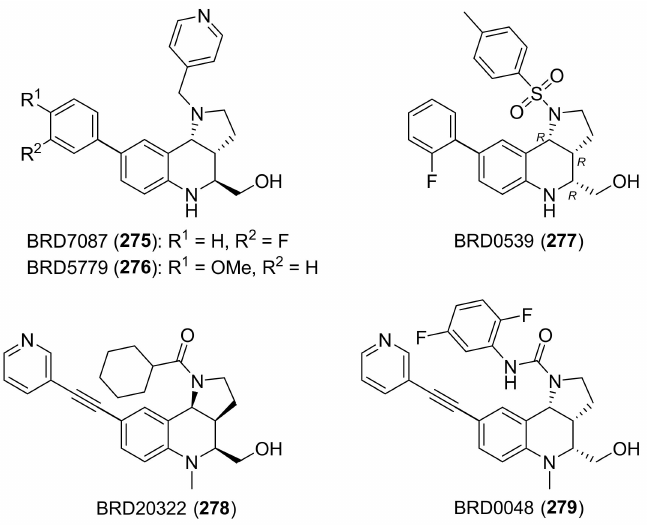
Figure 7. Inhibitors of DNA endonuclease Cas9 in Streptococcus pyogenes ( 275 – 277 ) and inhibitors of the transcription activation complex, comprised of dCas9:gRNA and transcription-activating SAM domains ( 278 – 279